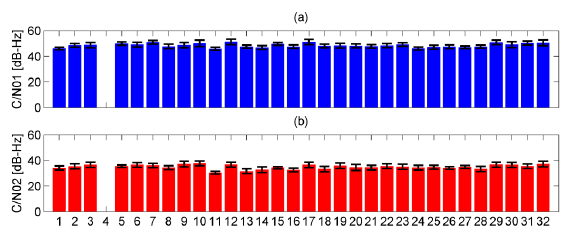
Figure 5. Mean C/N0 values of each satellite, where the error bars are the one-time STD ranges for each satellite. ( a ) C/N0 of C1 (C/N01); and ( b ) C/N0 of P2 (C/N02). Remote Sens. 2018 , 10 , x FOR PEER REVIEW